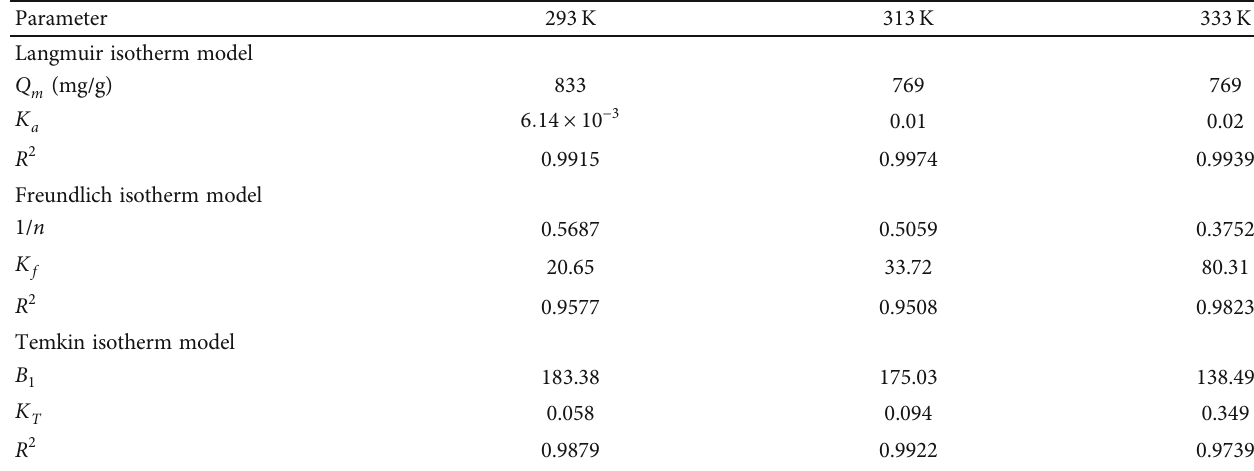
(a) Isothermal parameters for the adsorption of safranin dye on the prepared